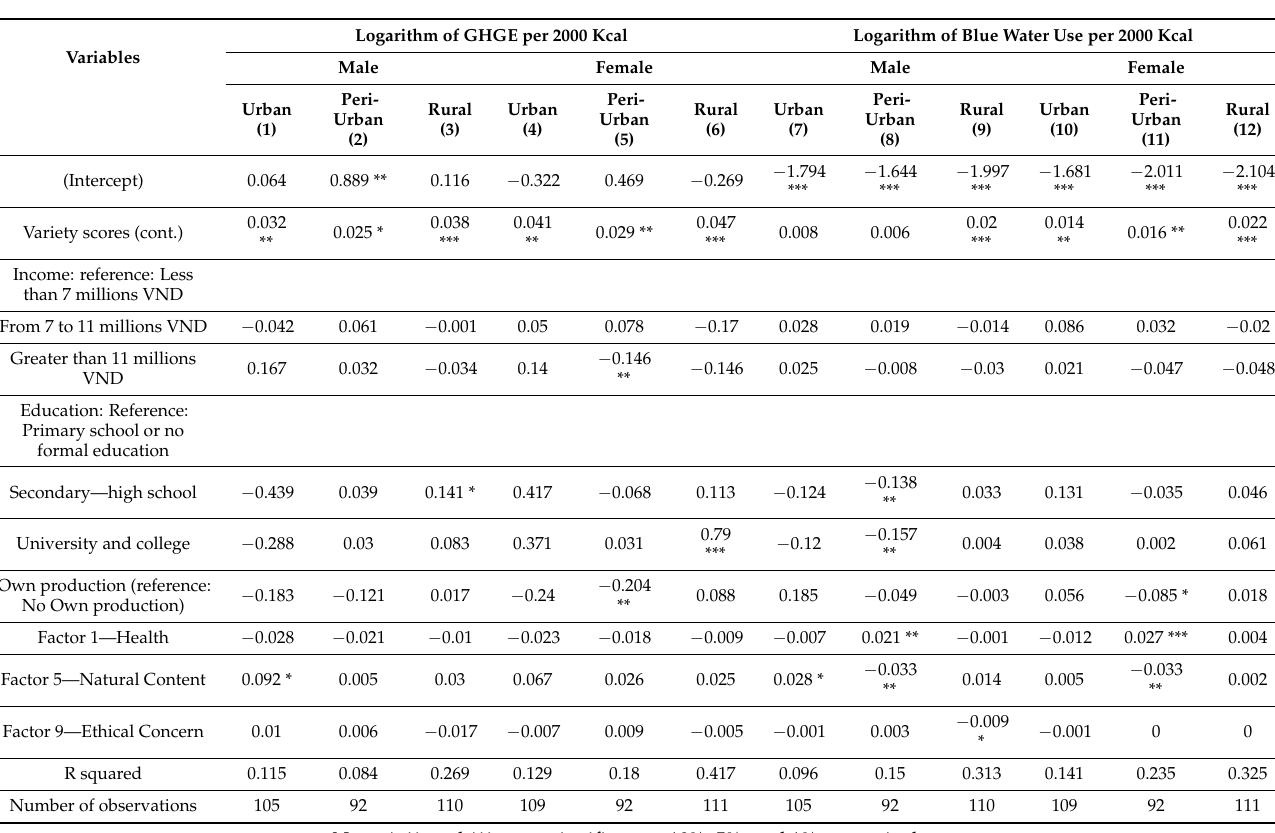
Table 3. Summary of regression